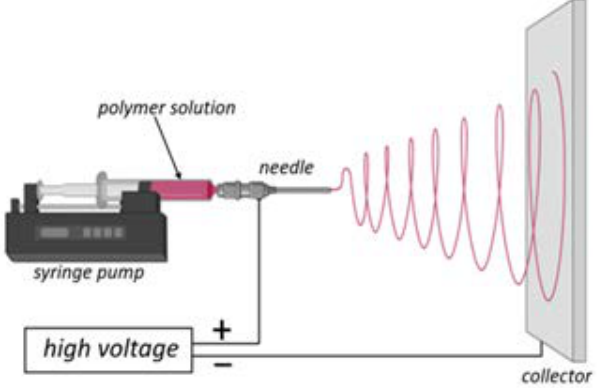
Figure 1. Schematic diagram of the electrospinning setup. Adapted from “FullTemplateName”, by BioRender.com (2022) [28] .